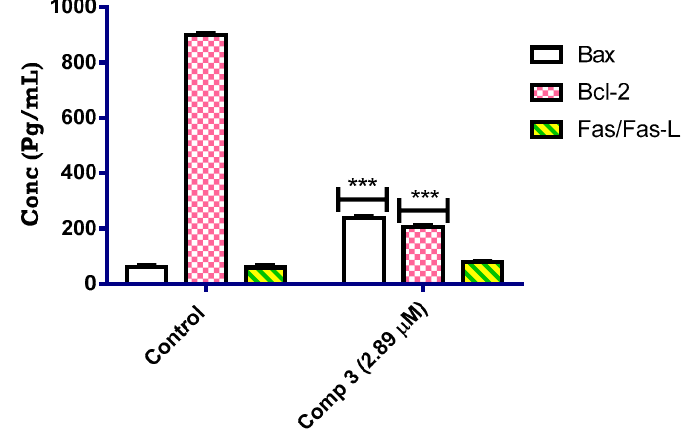
Figure 6. Effect of compound 3 on apoptosis related proteins, Bax, Bcl2, and Fas/Fas-L in MCF-7 cells. The graph represents the increased expression of Bax and decreased expression of Bcl2, during apoptotic event that occurred after the treatment of compound 3 (2.89 µ M) in MCF-7 cells and was determined by ELISA assay. Data was expressed as mean ± SD ( n = 3 experiments) and statistical comparisons were carried out using one-way analysis of variance (ANOVA) followed by Tukey’s multiple comparison test (*** p < 0.001).